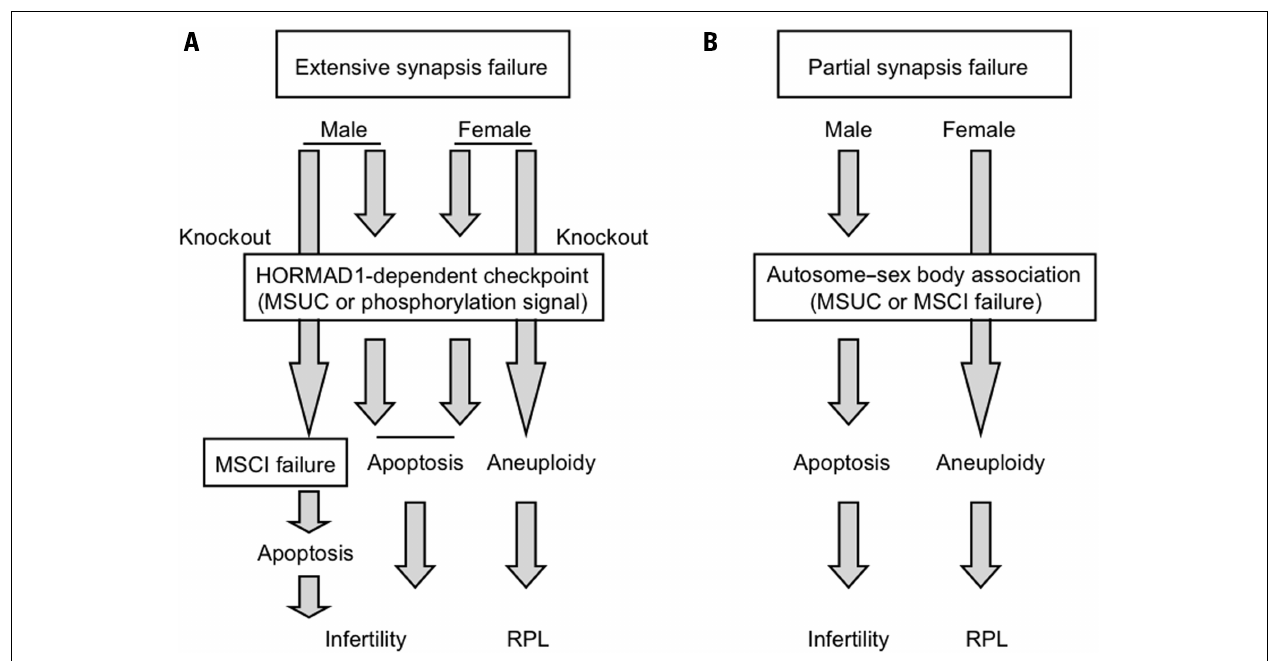
FIGURE 4 | Putative mechanism of the DSB-independent surveillance system for synapsis during meiosis I. (A) Surveillance system for detecting extensive synapsis failure that is typically observed in Spo11 deficiency. (B) Surveillance system for detecting partial synapsis failure that is typically observed in translocation